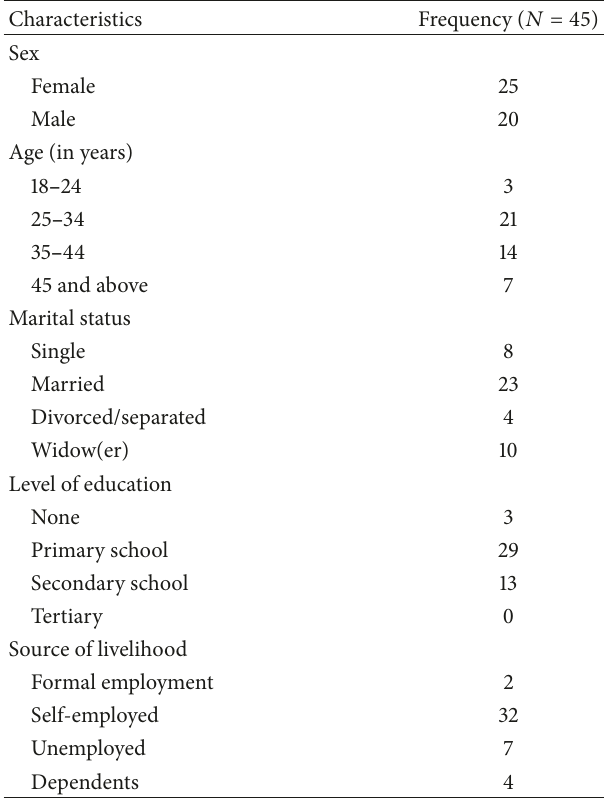
Table 1: Characteristics of ART patients who participated in the study.